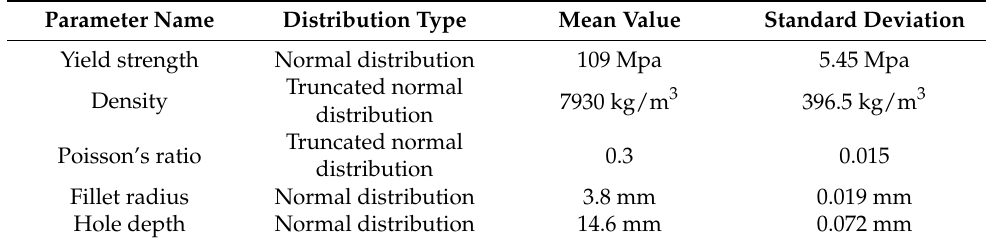
Table 1. Distribution characteristics of uncertain parameters.